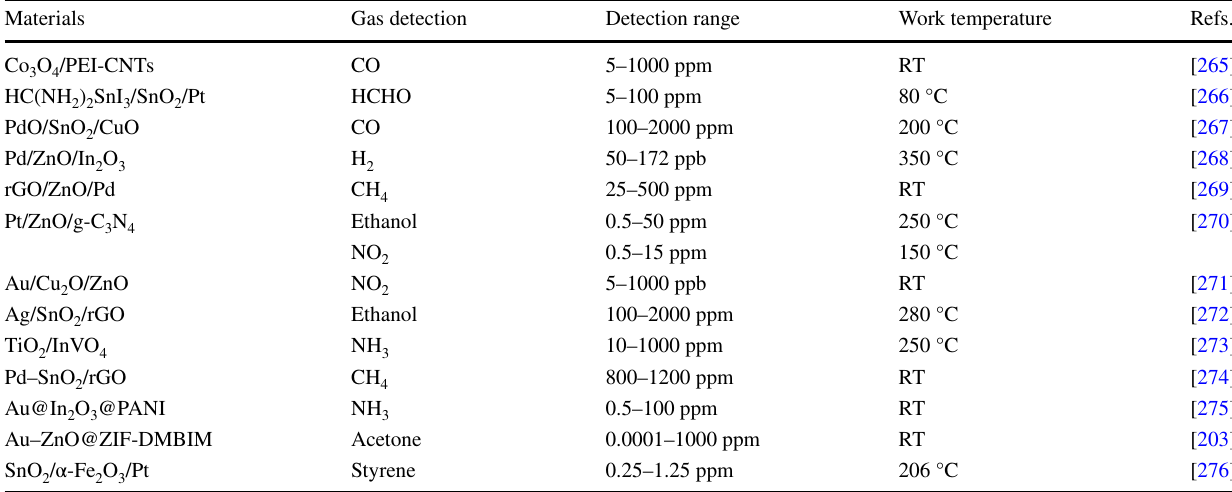
Table 6 Representative works based on combined mechanisms Materials Work